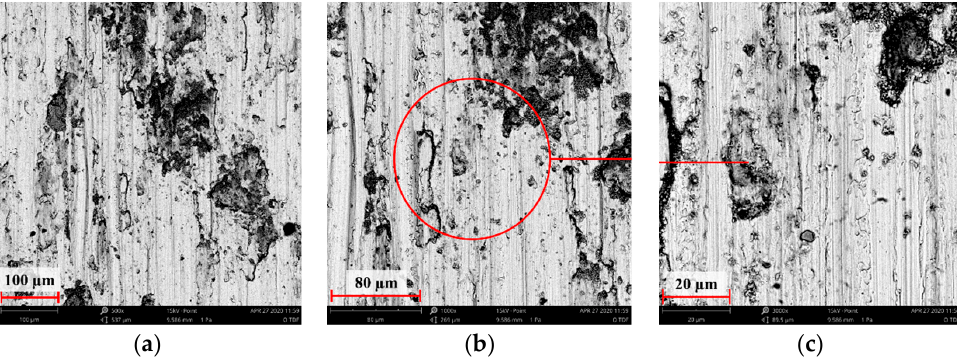
Figure 22. SEM image of the oxygen ion-implanted steel 316L wear track after dry sliding: ( a ) ×500, ( b ) ×1000, ( c ) ×3000.